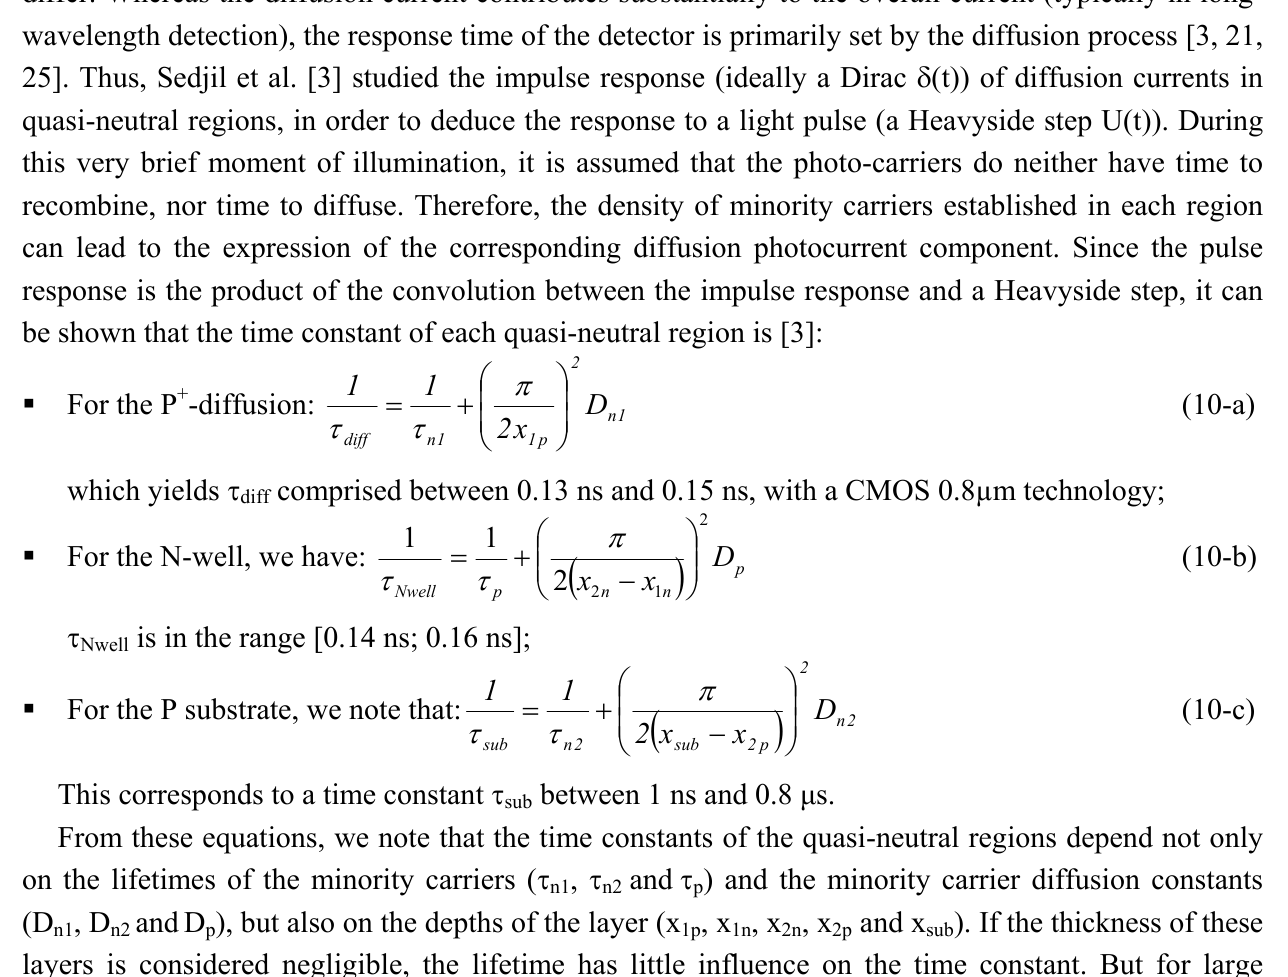
and J junctions in dark, for a 50 x 50 1 2